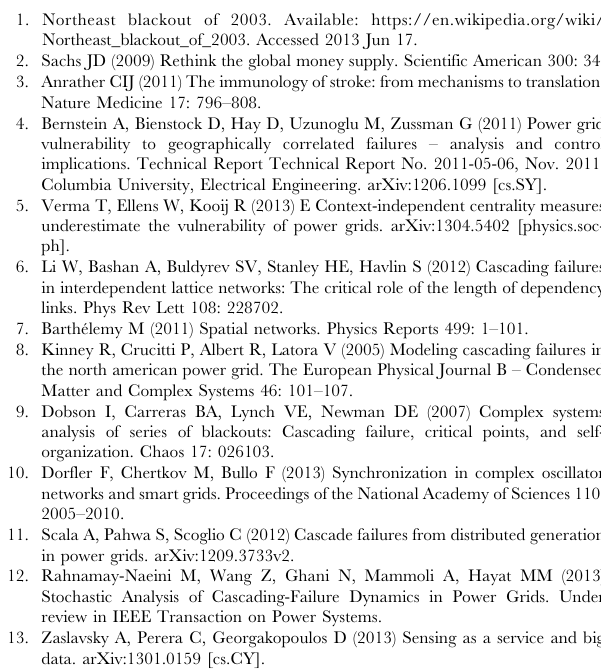
Figure S2 Effect of rewiring links in an RGG with link- length dependent conductances . As the rewiring probability p is increased, the non-monotonicities in G as a function of tolerance parameter a gradually disappear, similarly to the case where link conductances are independent of their length (see Fig. 5). Simulations were performed with N ~ 1300 and S k T ~ 5 . Movie S1 Progression of the cascade initiated by the removal of the node with the highest load on the UCTE network ( N = 1254) with tolerance parameter a =0.45. Node sizes are proportional to the load on them. The single orange node at the beginning of the movie indicates the node with overloaded nodes in subsequent stages are shown in orange